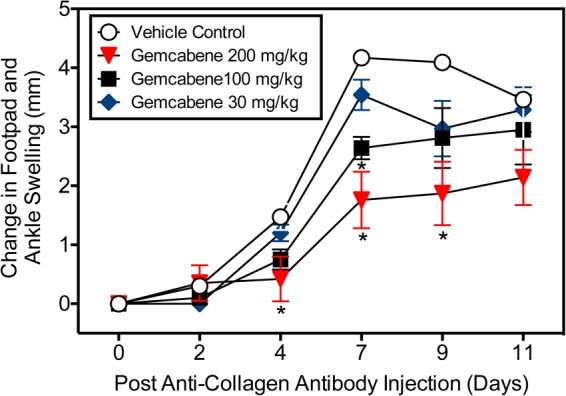
Collagen antibody-induced joint swelling and arthritis in female BALB/c mice. Joint swelling and arthritis were induced in BALB/c mice by collagen antibody injection. Mice were dosed orally with vehicle (0.5% hydroxypropyl methylcellulose/0.25% Tween-80), or gemcabene at 30, 100, or 200 mg/kg in vehicle, 1 h prior to LPS injection, and then q.d. thereafter for the duration of the study. Change in footpad and ankle swelling was measured as described in the “Experimental Procedure” section. ∗Indicates statistical significance (p < 0.05). Data are expressed as Mean ± SEM.